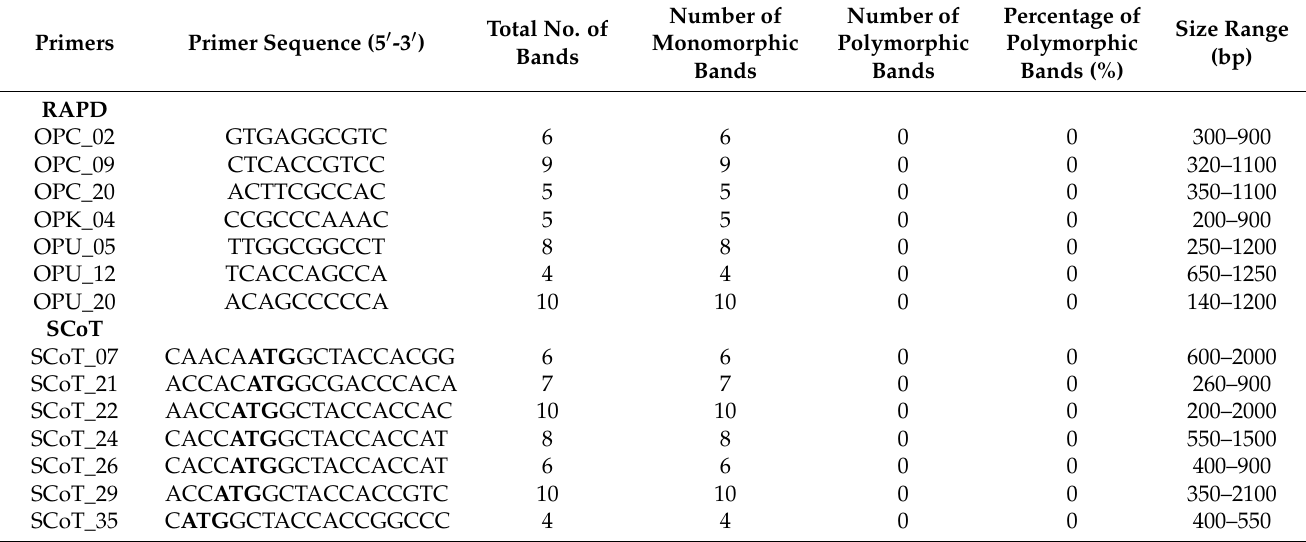
Table 4. The nucleotide sequences of primers used for RAPD and SCoT molecular marker analysis.